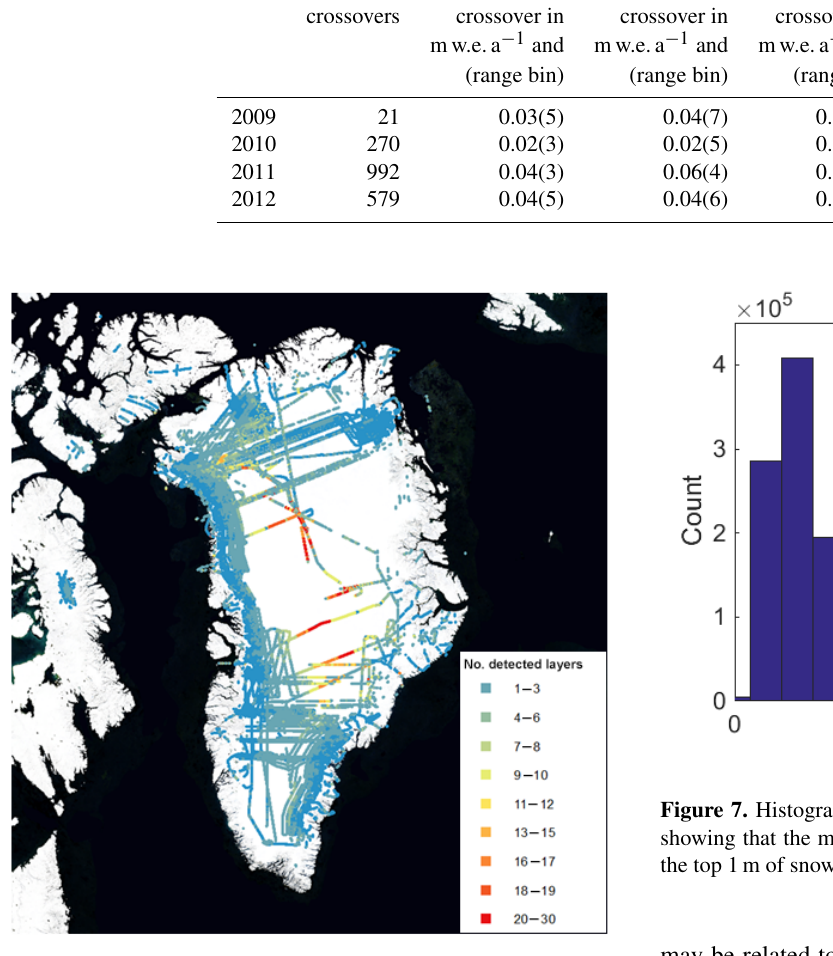
Figure 6. Number of detected annual layers from 2009 through 2012 showing that, for the majority of the GrIS, fewer than three layers, or previous years of accumulation, were detected.